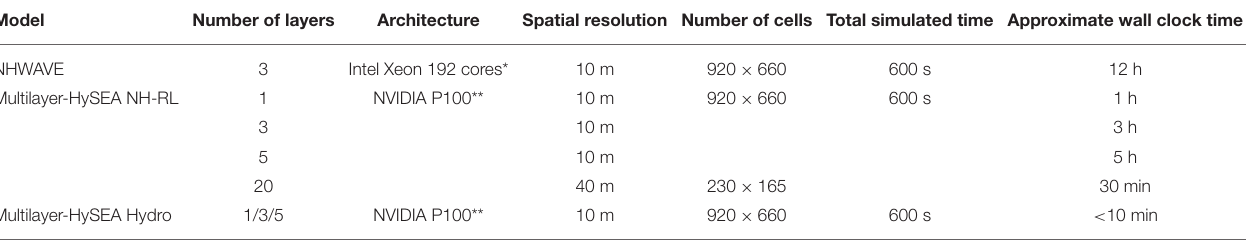
TABLE 4 | Computational effort for the benchmark test using different numerical models and grid resolutions.